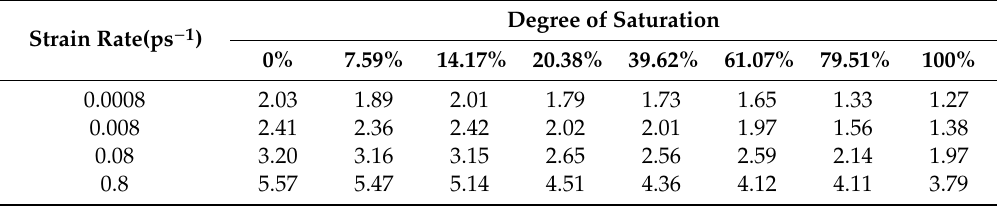
Table 1. Tensile strength of C–S–H with different degree of saturation under different strain rates (GPa).